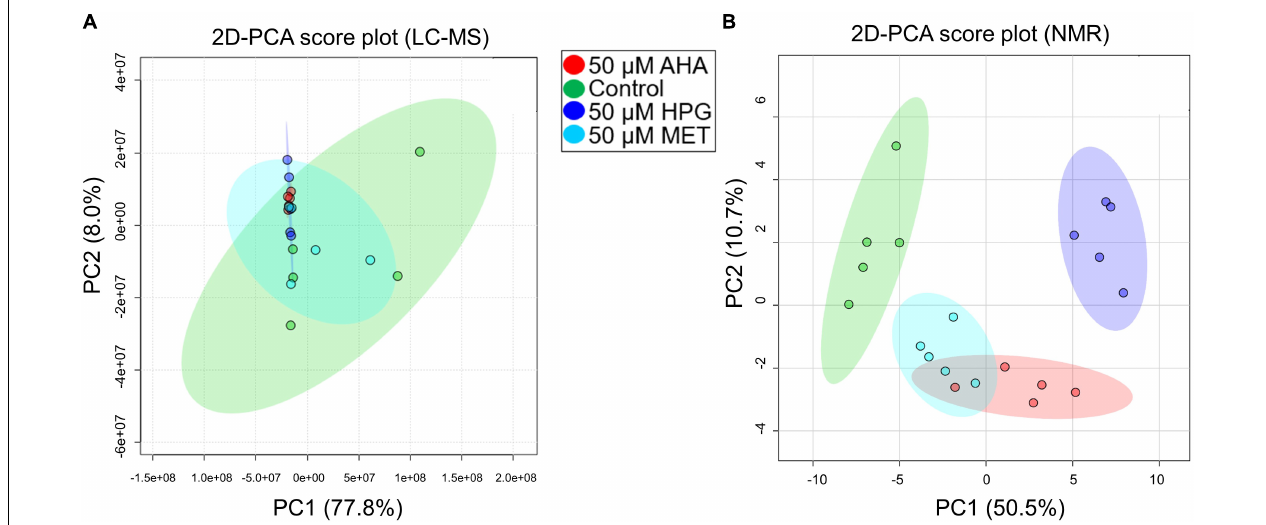
FIGURE 3 | 2D PCA plot of MS features and NMR features of heat stressed E. coli cultures. (A) MS data and (B) NMR data are shown. (A) The variation within the control group in the MS data completely encompasses the spread of the other sample types. (B) Experimental groups show partial separation by NMR. Data is similar to the MS non-stressed PCA plot in that E. coli cells with HPG have the greatest